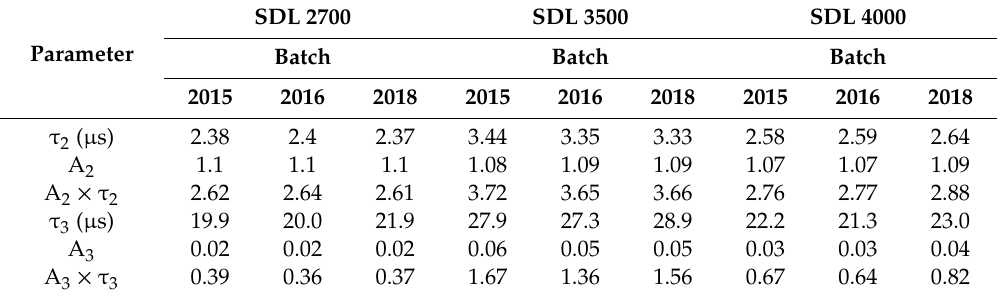
Table 3. Decay time ( τ i ), amplitude (A i ), and light sum (A i × τ i ) of slow components of the kinetics of